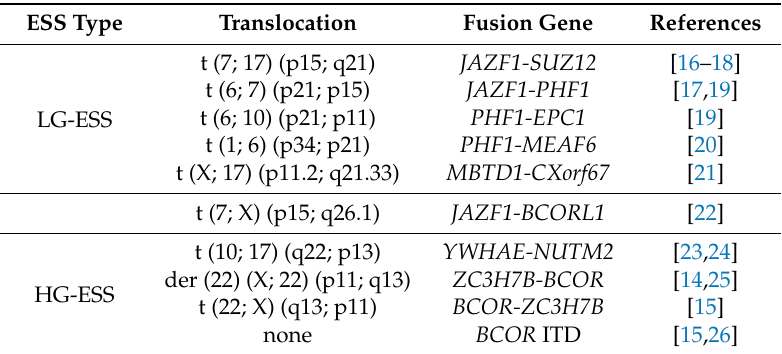
Table 2. Genetic profiles of ESS